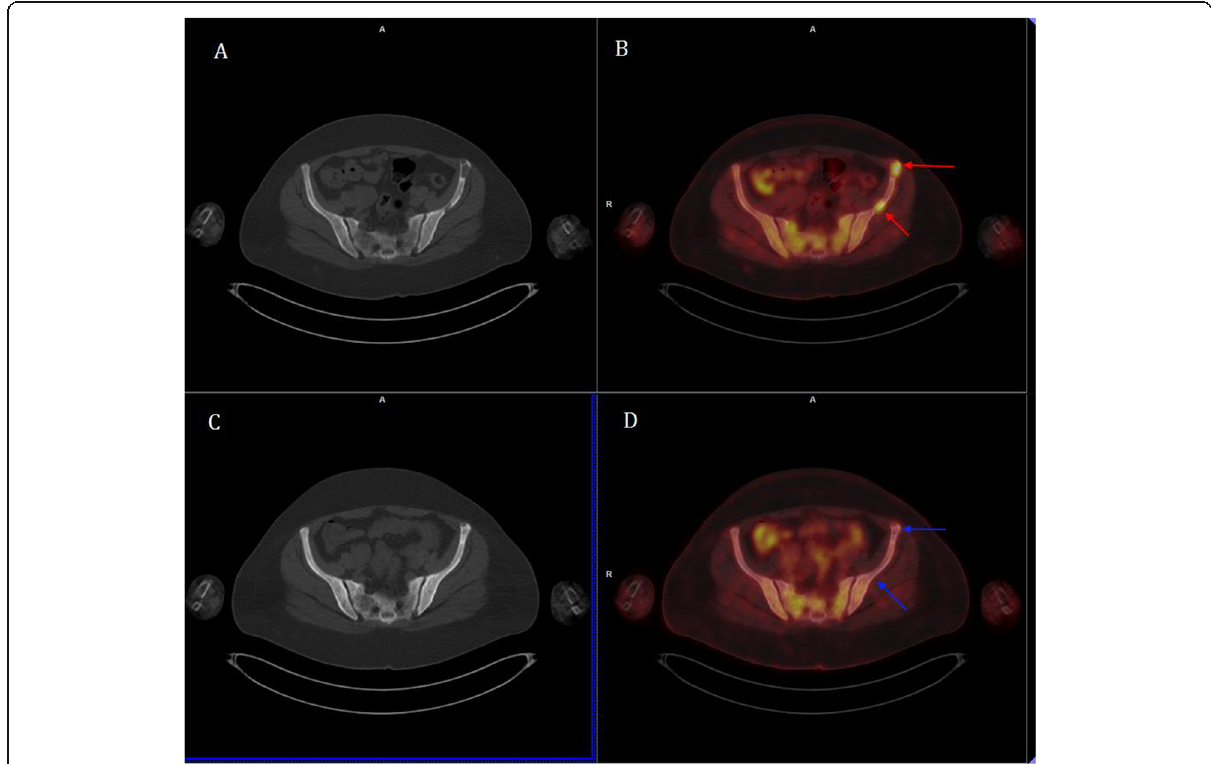
Fig. 7 Preoperative and postoperative axial CT and fused 18 F-FDG PET/CT images: A , B (preoperative) images show hypermetabolic left iliac lytic bone lesions (red arrows) that show complete metabolic resolution in the postoperative 18 F-FDG PET/CT images ( C , D ) (blue